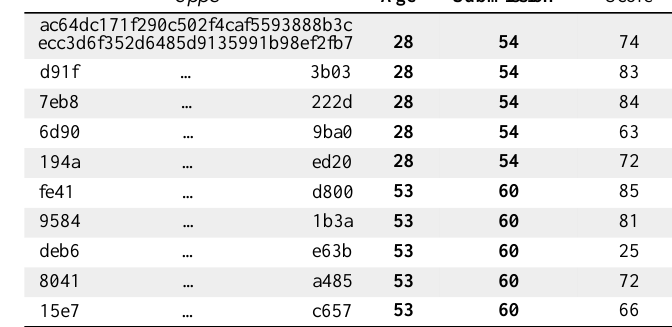
Figure 4. ( a ) Data partition sent by the provider P a during the confidential data collection (step 9 of the protocol). ( b ) Data partition sent by the provider P b during the confidential data collection (step 9 of the protocol). Quasi-identifier attributes are marked in bold. The asterisk identifies the masked